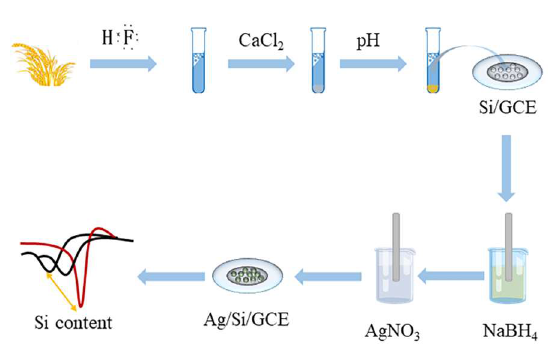
Figure 1. Schematic diagram of electrochemical sensor fabrication.